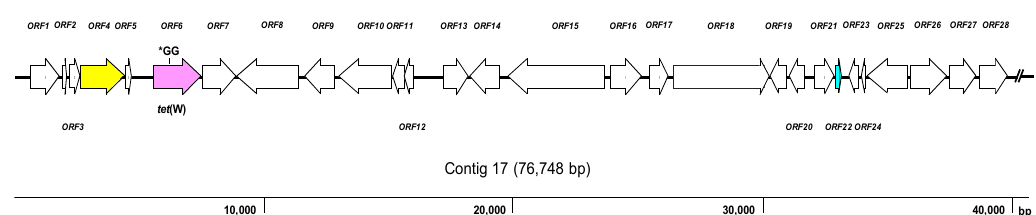
Figure 3. Diagram showing the genetic organization of ORFs in the contig harboring the tet (W) gene of Bifidobacterium bifidum VA07-1AN. Color key: purple, tet (W) gene (the position of the GG insertion disrupting the ORF is indicated); yellow, conjugation-associated gene; pale blue, gene encoding a transcription regulator; white, genes involved in other processes. The broken line symbol indicates the contig extends beyond this point.